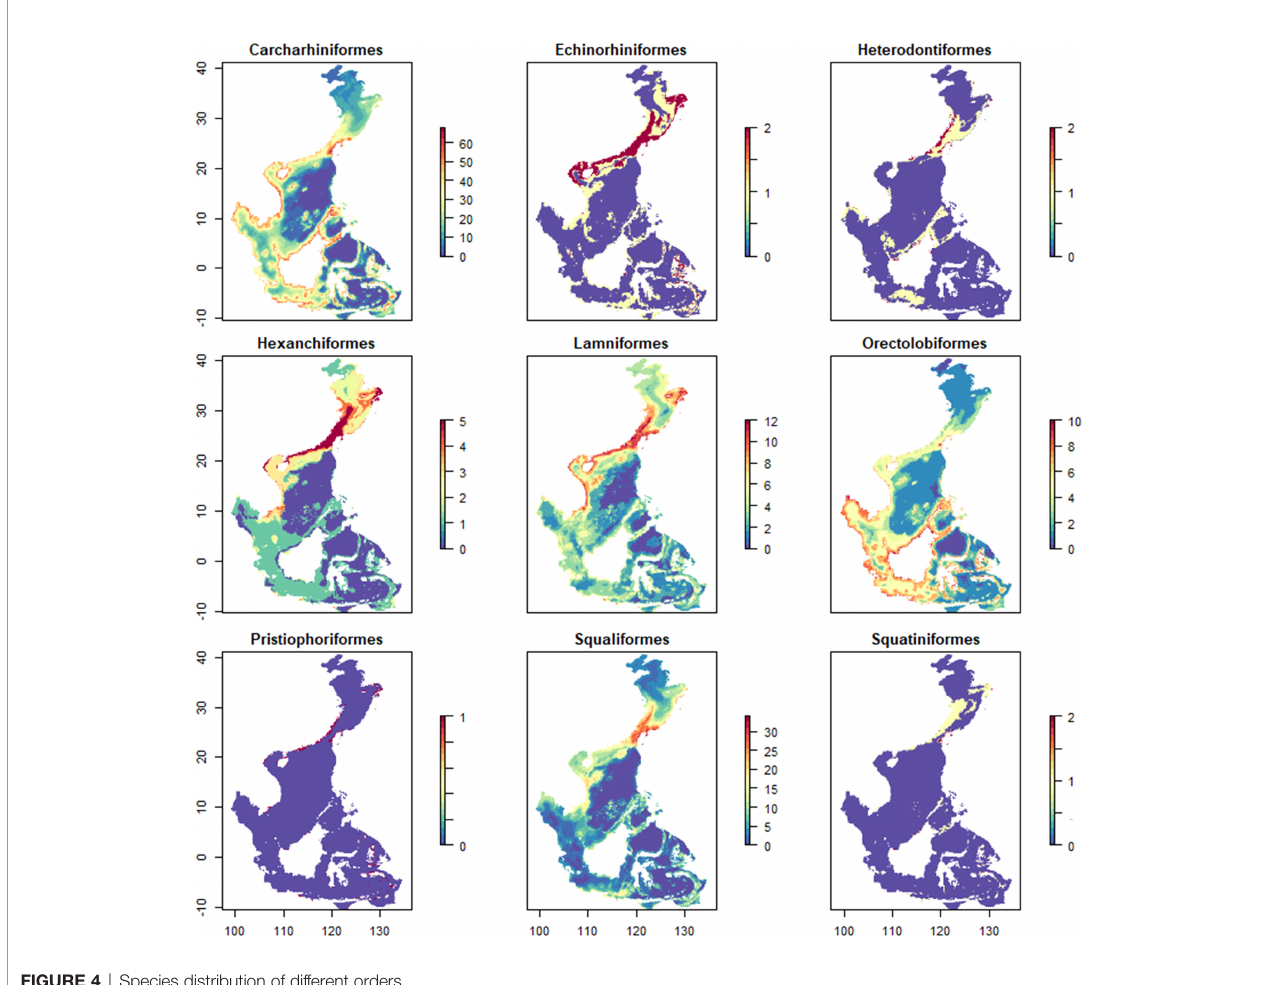
FIGURE 4 | Species distribution of different orders.